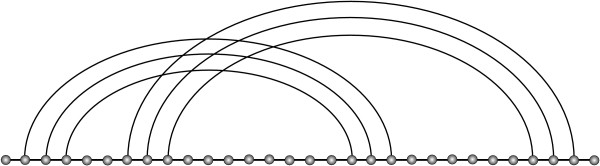
Motif. A 3-noncrossing, 3-canonical motif.